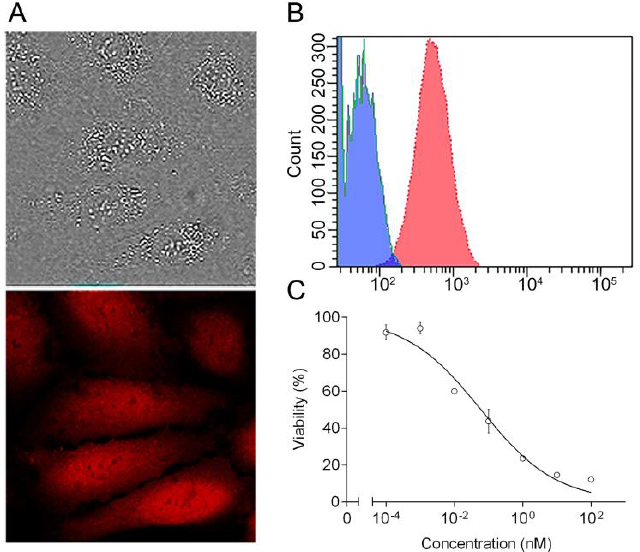
Figure 6. Fluorescent human ovarian carcinoma cells SKOVip-kat and their response to DARPin-LoPE treatment in vitro. ( A ) Visualization of SKOVip-kat cells expressing protein Katushka (red) in transmitted light (on the top) and by confocal microscopy (on the bottom). Image size 135 × 135 µ m; ( B ) Analysis of surface content of the HER2 protein on SKOVip-kat cells stained with FITC-labeled anti-HER2 antibody (red filling) or with FITC-labeled isotypic control (blue filling) and analyzed by flow cytometry; ( C ) Relative viability of SKOVip-kat cells in 2D monolayer culture (MTT assay) after a 72 h treatment with different concentrations of DARPin-LoPE. The data are represented as mean ± SEM.